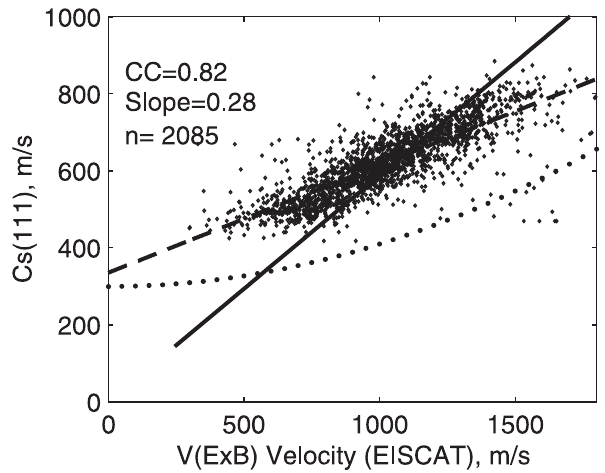
Fig. 7. A comparison of the measured ion-acoustic speed at 111km and the predicted one from the empirical equation by Nielsen and Schlegel (1985). The dependence V = βV E ( β =0.588) used in the model by Uspensky et al. (2004) is shown by the solid